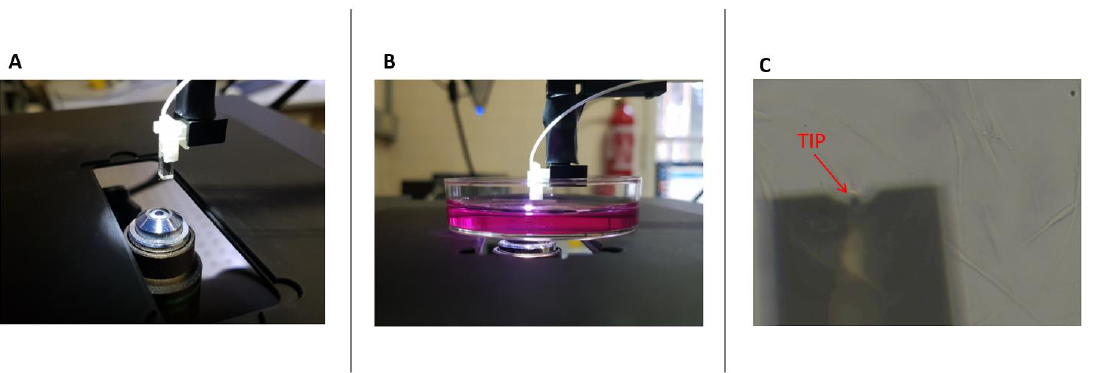
Figure 2. Indentation setup. ( A ) Alignment of the microscope objective with the nanoindentation probe. ( B ) Sample on the objective, during an indentation experiment. ( C ) Phase contrast image of the cantilever approaching a cell layer.